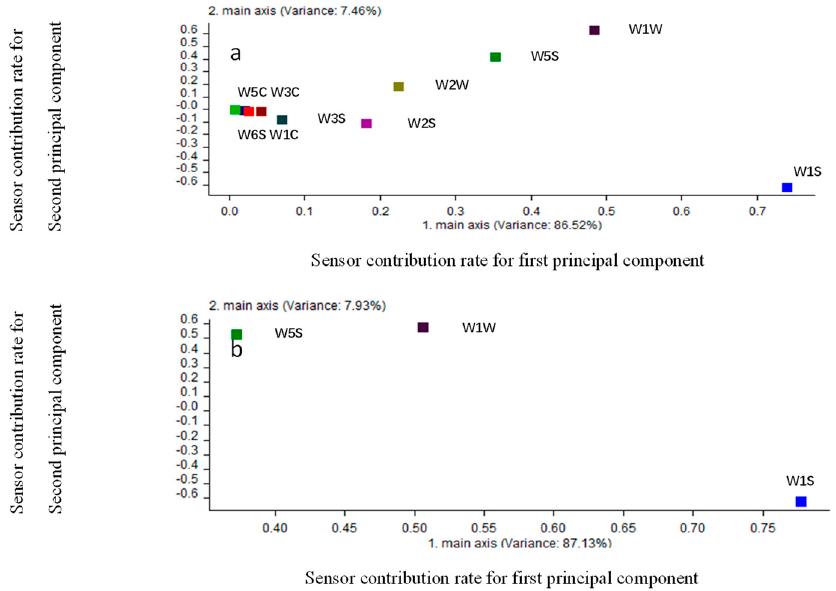
Figure 3. LO analysis of the tested peach germplasms. Note: ( a ) Load analysis based on the ten sensors; ( b ) Load analysis based on the three main sensors. W1S: sensor for methane compounds; W1W: sensor for hydrogen sulfide; W5S: sensor for nitrogen oxides; W2W: sensor for aromatic components and organic sulfide; W2S: sensor for broad-alcohol; W3S: sensor for methane-aliph; W6S: sensor for hydrogen; W1C: sensor for aromatic benzene; W3C: sensor for ammonia; and W5C: sensor for arom-aliph.